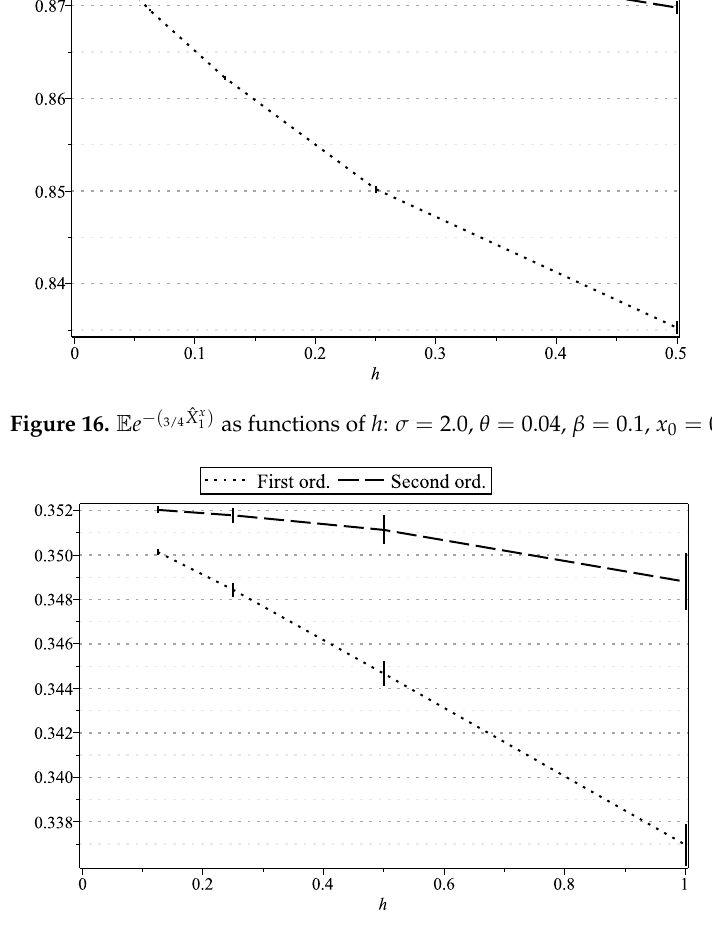
Figure 17. E e − ( 5/6 ˆ X x 1 ) as functions of h : σ = 0.8, θ = 0.5, β = 0.5, x 0 =